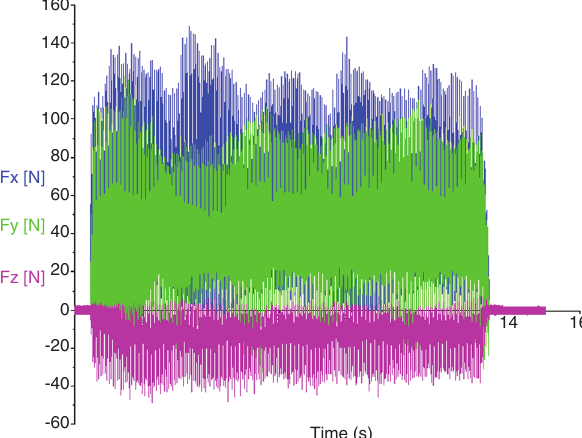
Figure 2 Cutting forces for three flutes, 30 m/min and 0.15